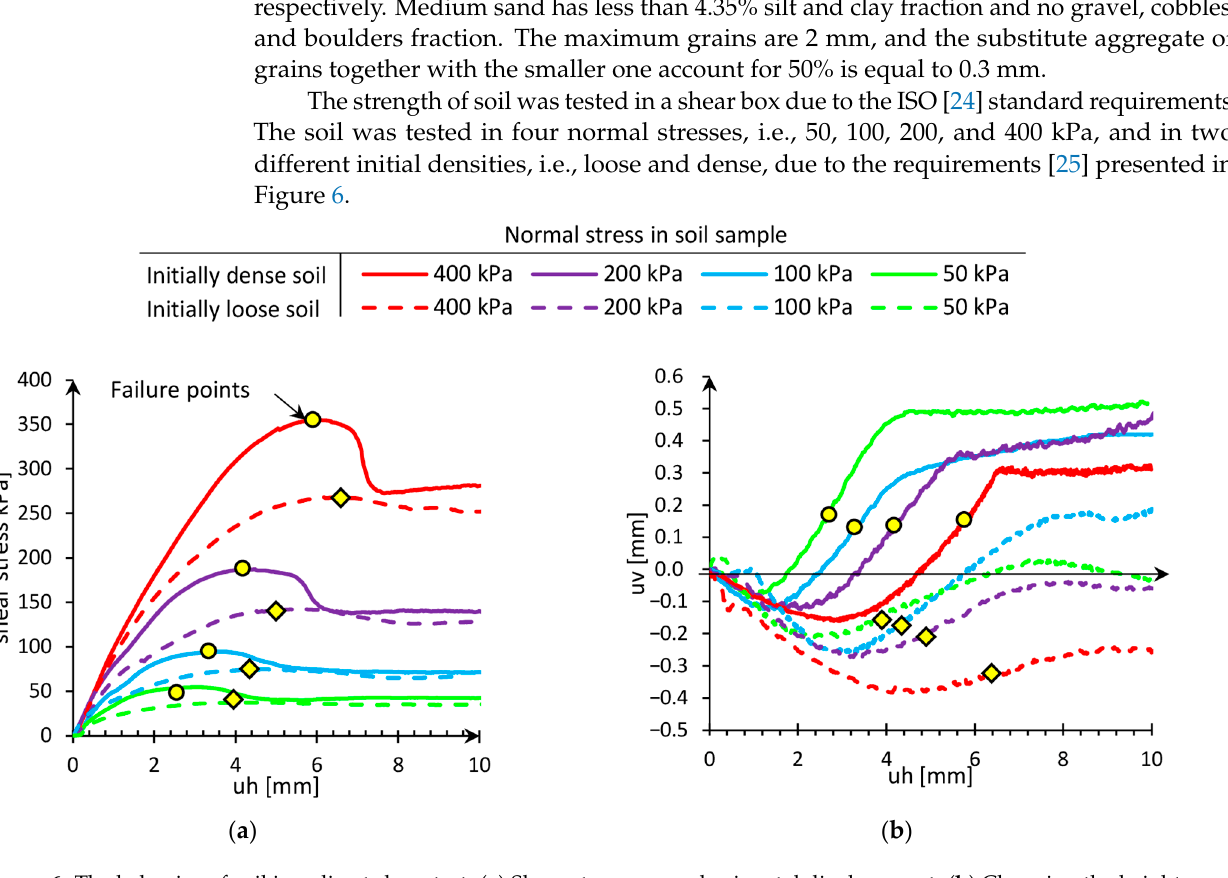
Figure 6. The behavior of soil in a direct shear test. ( a ) Shear stress versus horizontal displacement. ( b ) Changing the height of the sample versus changing horizontal displacement.